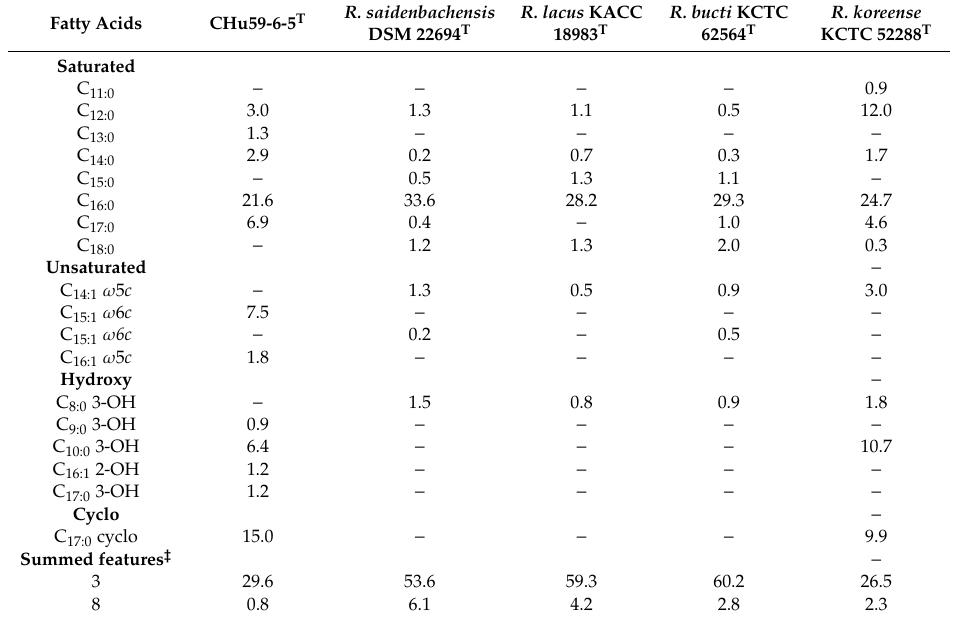
Table 2. Cellular fatty acid compositions (%) of strain CHu59-6-5 T and the type strains of related species of the genus Rhodoferax